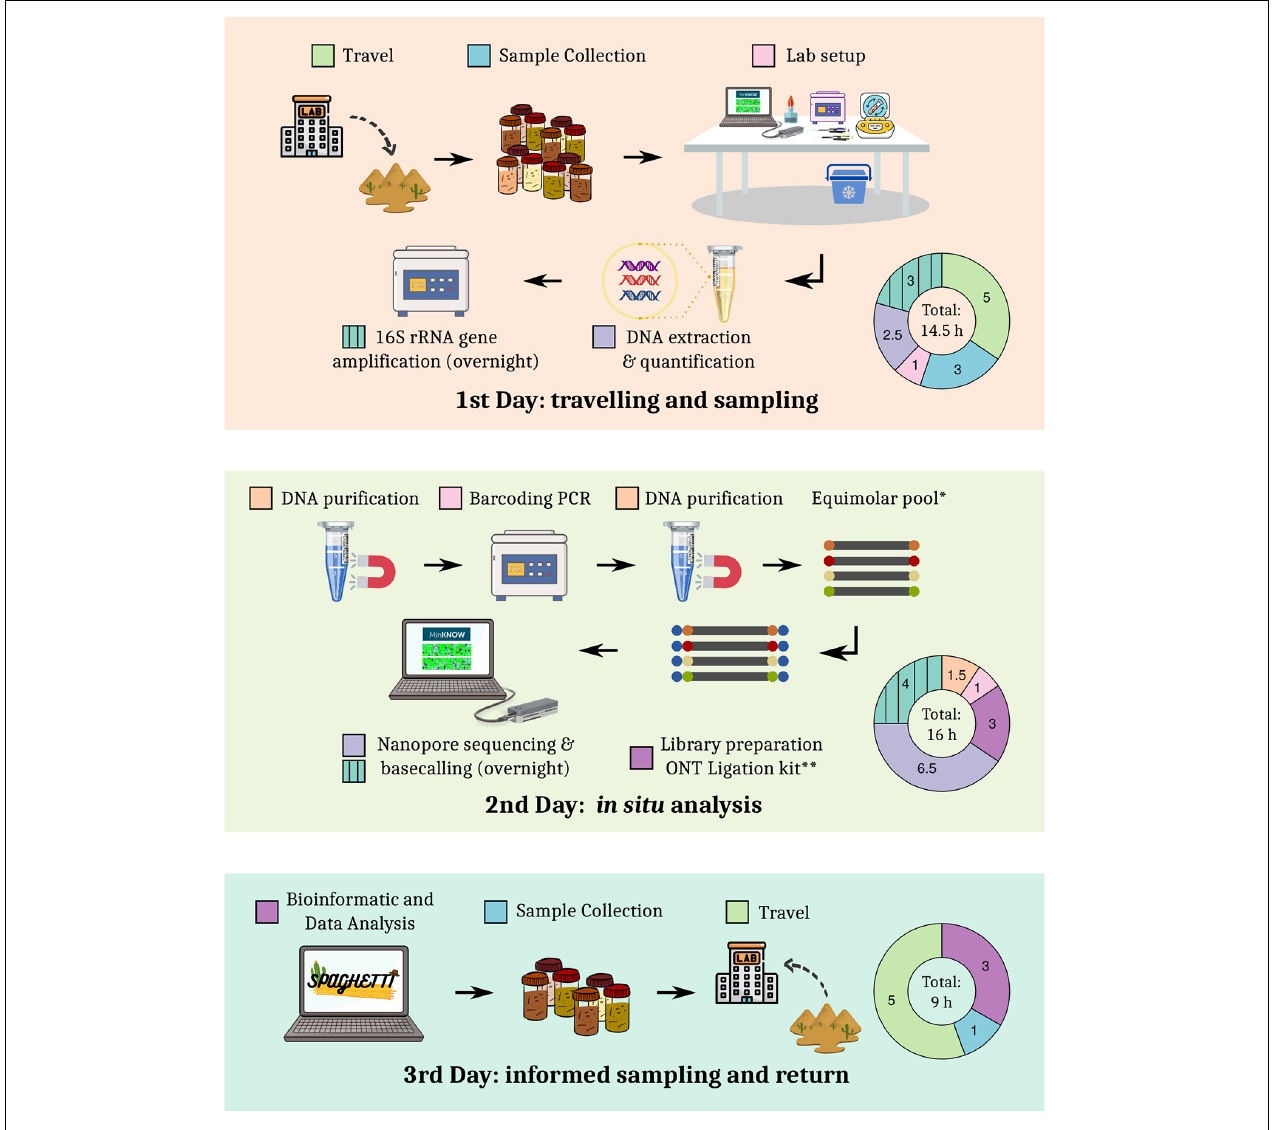
FIGURE 1 | Detailed roadmap of the sampling